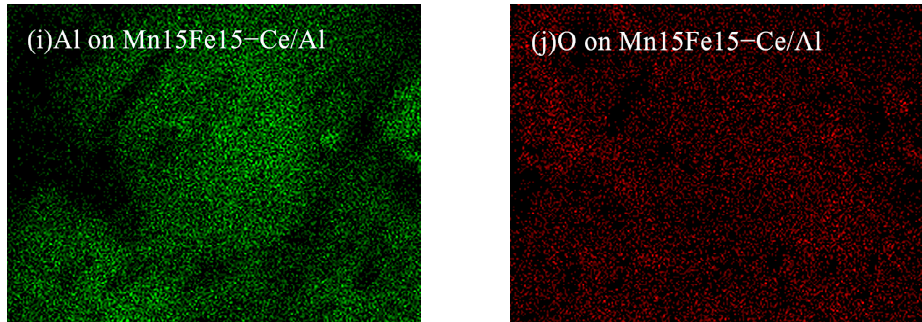
Figure 1. Scanning electron microscopy (SEM), transmission electron microscopy (TEM) and mapping of Mn − Fe − Ce − O x / γ‐ Al 2 O 3 nanocatalysts: ( a ) SEM of Mn10Fe20 − Ce/Al; ( b ) SEM of Mn15Fe15 − Ce/Al; ( c ) SEM of Mn20Fe10 − Ce/Al; ( d ) TEM of Mn15Fe15 − Ce/Al; ( e ) mapping of Mn15Fe15 − Ce/Al; ( f ) mapping of Mn on Mn15Fe15 − Ce/Al; ( g ) mapping of Fe on Mn15Fe15 − Ce/Al; ( h ) mapping of Ce on Mn15Fe15 − Ce/Al; ( i ) mapping of Al on Mn15Fe15 − Ce/Al; ( j ) mapping of O on Mn15Fe15 − Ce/Al.